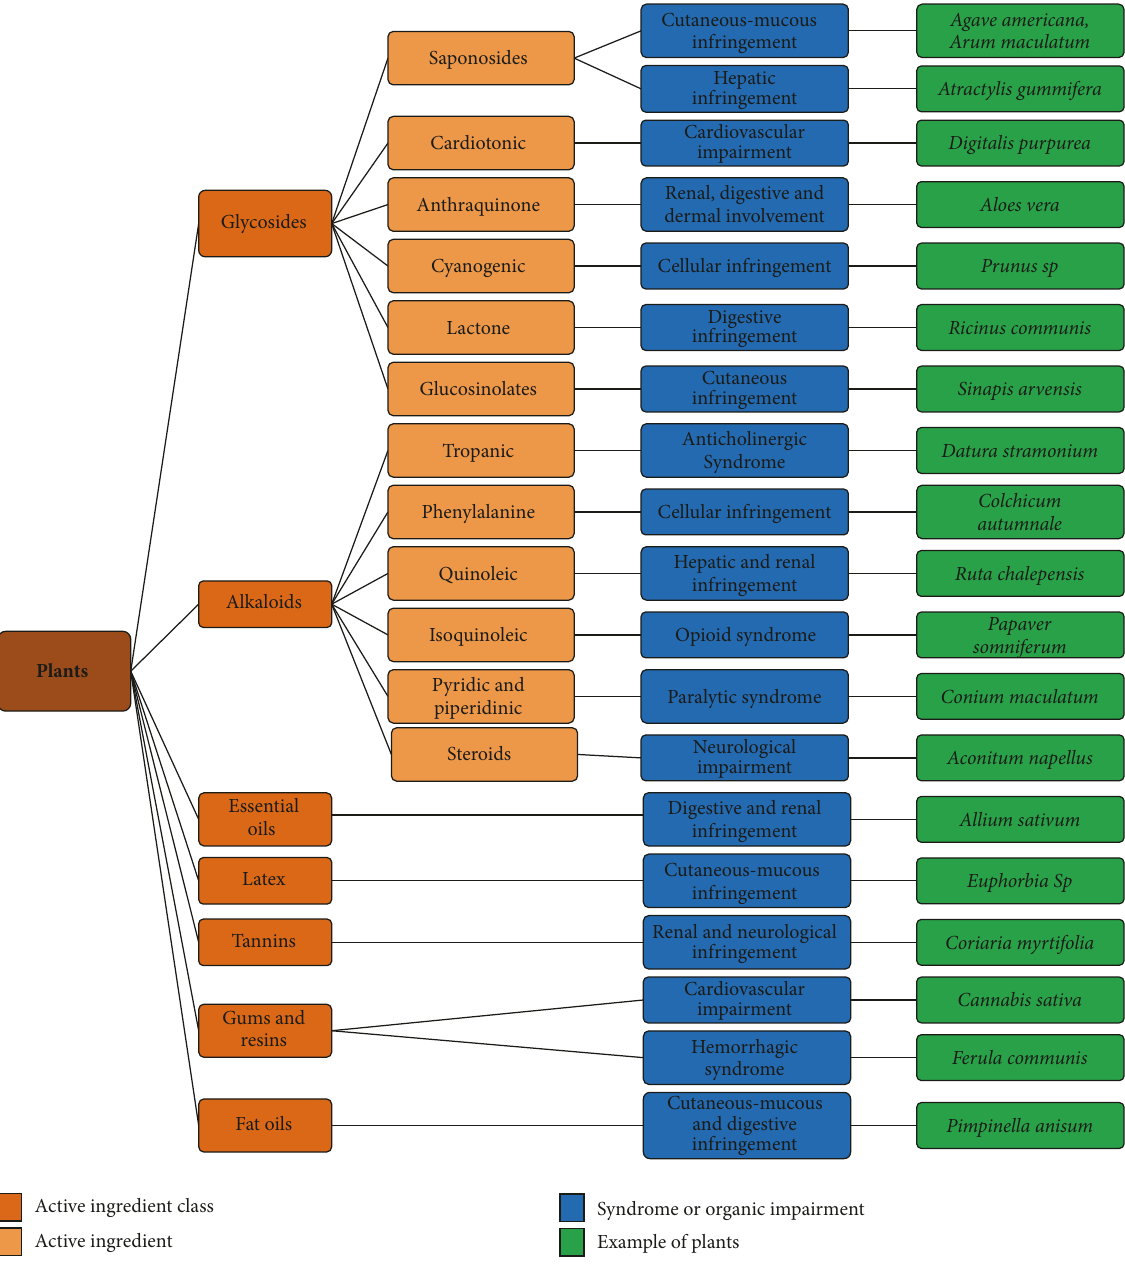
Figure 1: Representative diagram of the classification of plants by organic attack according to the active principle; with some examples from the CAPM database